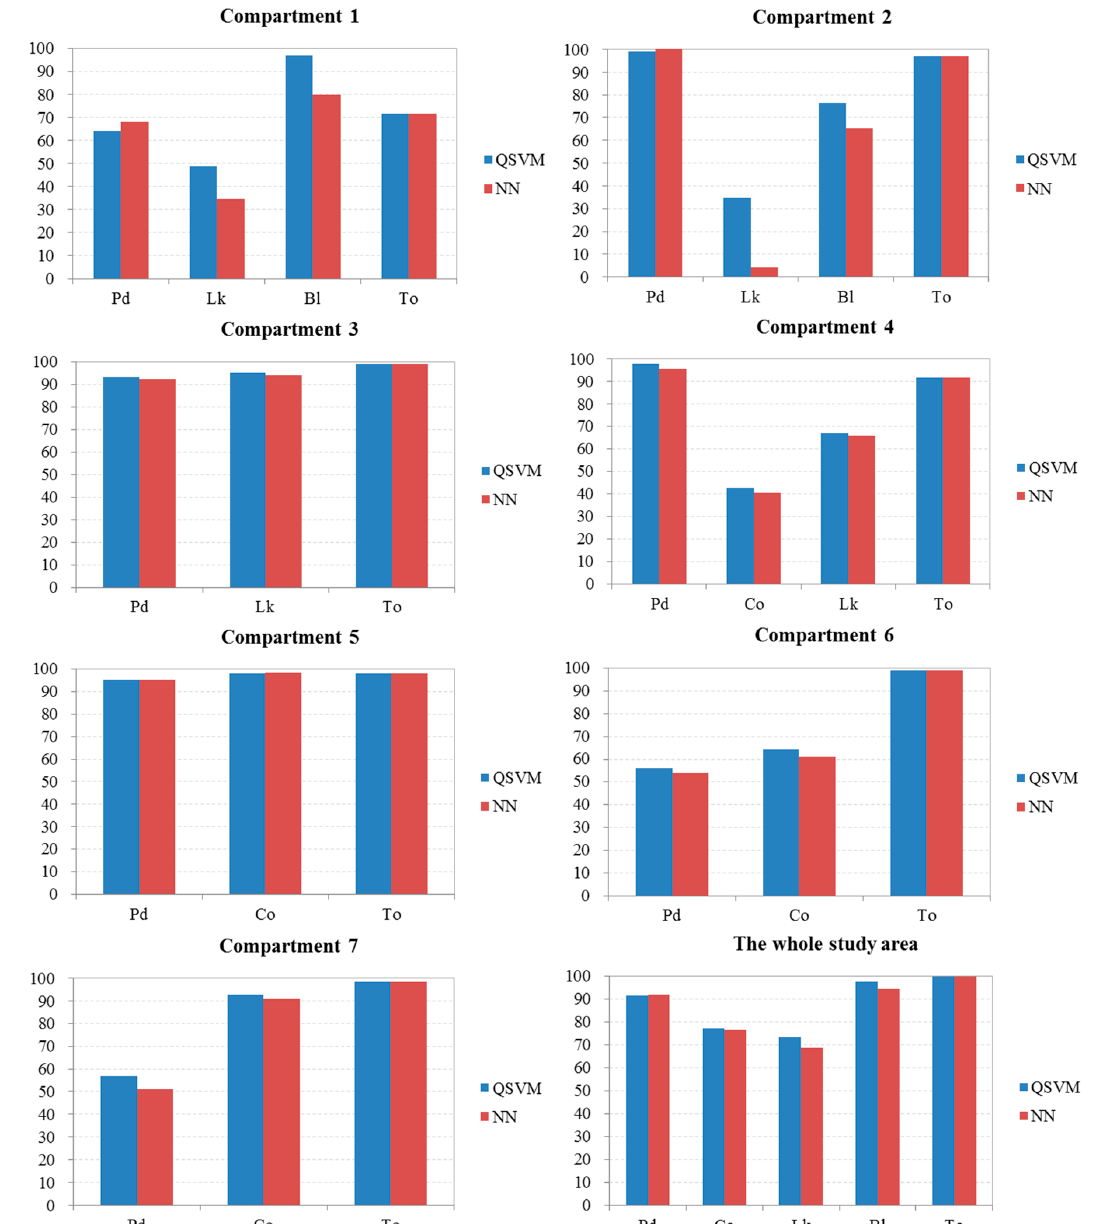
Figure 11. A comparison of the accuracies of the dominant tree species in each compartment and the entire study area interpreted using the quadratic SVM (QSVM) and neural network (NN) approaches. Pd, Pinus densiflora ; Co, Chamaecyparis obtusa ; Lk, Larix kaempferi ; Bl, broadleaved trees; To, total accuracy of the detected tree crowns versus the surveyed trees.